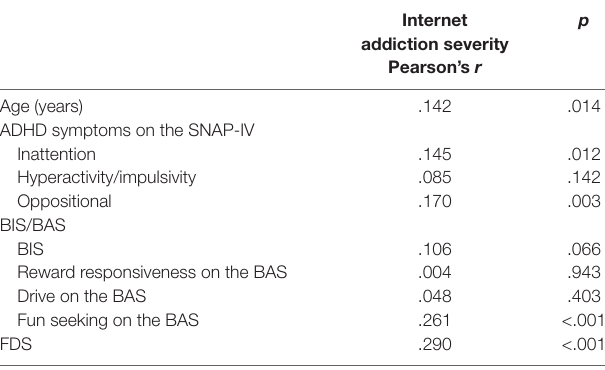
TABLE 2 | Correlation of age, ADHD symptoms, BIS/BAS, and FDS with internet addiction severity: Pearson’s